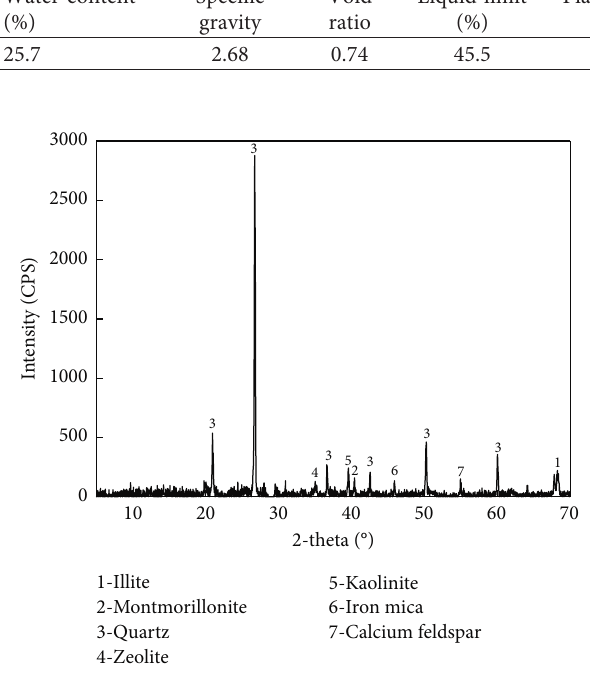
Figure 1: Mineral compositions of the tested soil.